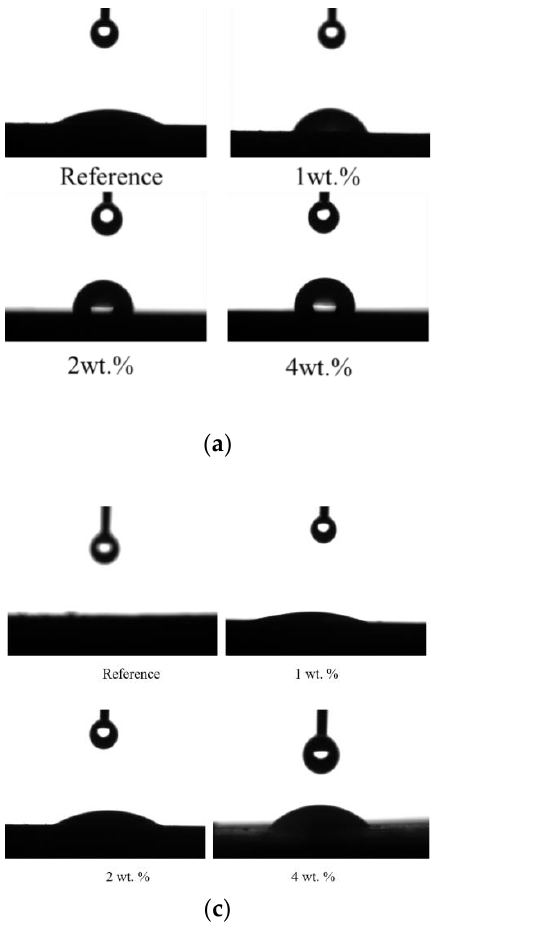
Figure 5. The contact angle results for both cement paste and concrete with different dosages of hydrophobic functional corrosion inhibitor at 28 d of curing. ( a ) Image of water droplets on cement paste sample; ( b ) contact angle; ( c ) image of water droplets on concrete samples; ( d ) contact angle.